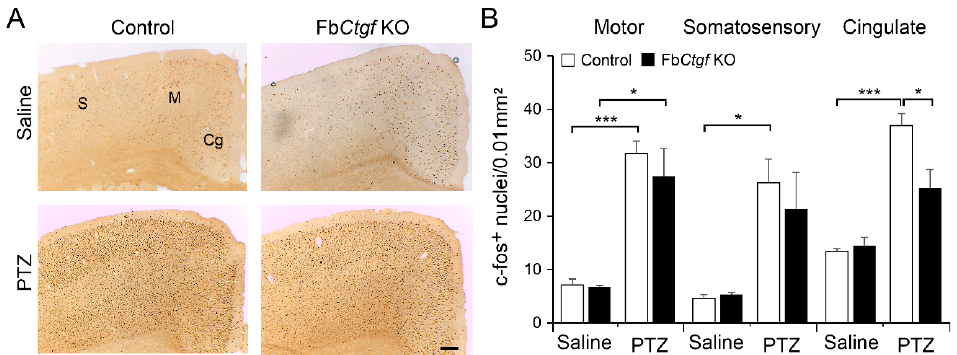
Figure 3. Expression of c-fos in the neocortex. Two hours after 50 mg / kg PTZ injection, animals were sacrificed for c-fos immunohistochemistry. The expression of c-fos was evident in the somatosensory (S), motor (M) and cingulate (Cg) cortices ( A ). Within these regions, the density of c-fos-positive nuclei was quantified ( B ). For saline group, n = 3 per genotype; for PTZ group, n = 5 per genotype. Results